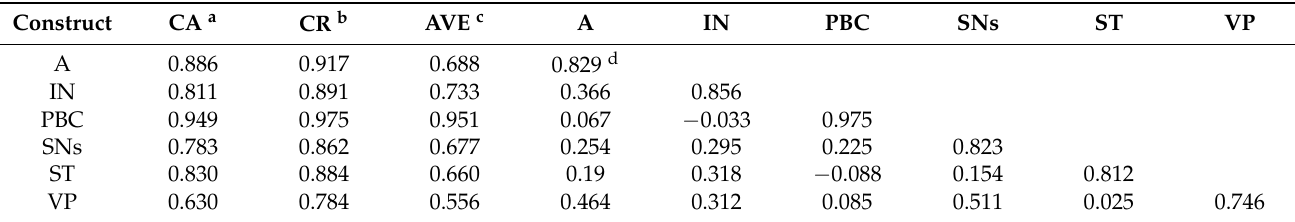
Table 4. Reliability and validity